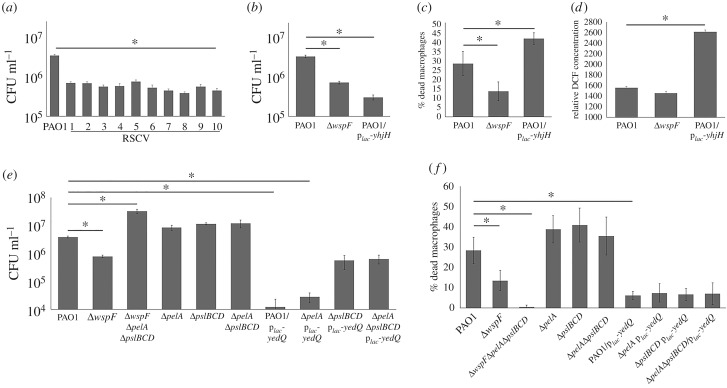
Adaptation to H2O2 provides further benefits by conferring protection against macrophages. (a) Quantification of phagocytosed PAO1 and evolved RSCV isolates by macrophages. (b) Quantification of phagocytosed PAO1, ΔwspF and PAO1/plac-yhjH strains by macrophages. (c) Cytotoxicity assay of macrophages by PAO1, ΔwspF and PAO1/plac-yhjH strains. (d) Quantification of ROS produced by macrophages in the presence of PAO1, ΔwspF, PAO1/plac-yedQ and PAO1/plac-yhjH strains using ROS detection assay. DCF (e) Quantification of phagocytosed PAO1 and ΔpslBCD strains by macrophages. (f) Cytotoxicity assay of macrophages by PAO1 and ΔpslBCD strains. Means ± s.d. from triplicate experiments are shown; p < 0.05, one-way ANOVA.